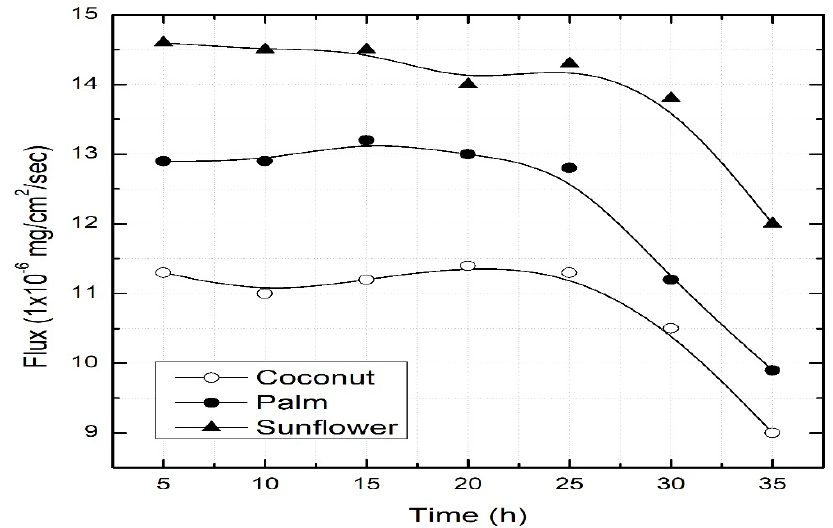
Figure 6. Membrane aging studies. Feed = 150 mg/L dye concentration at pH 11; strip = 0.25 M HCl.